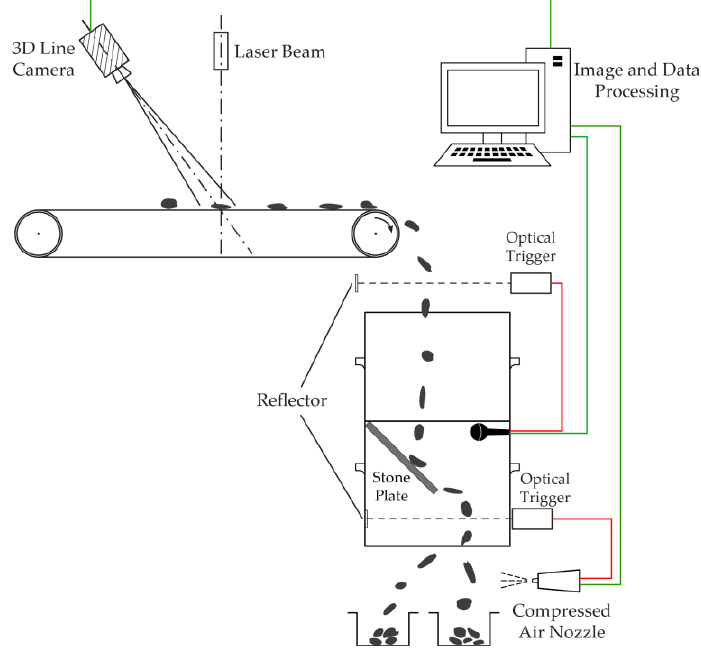
Figure 3. Experimental facility installation.